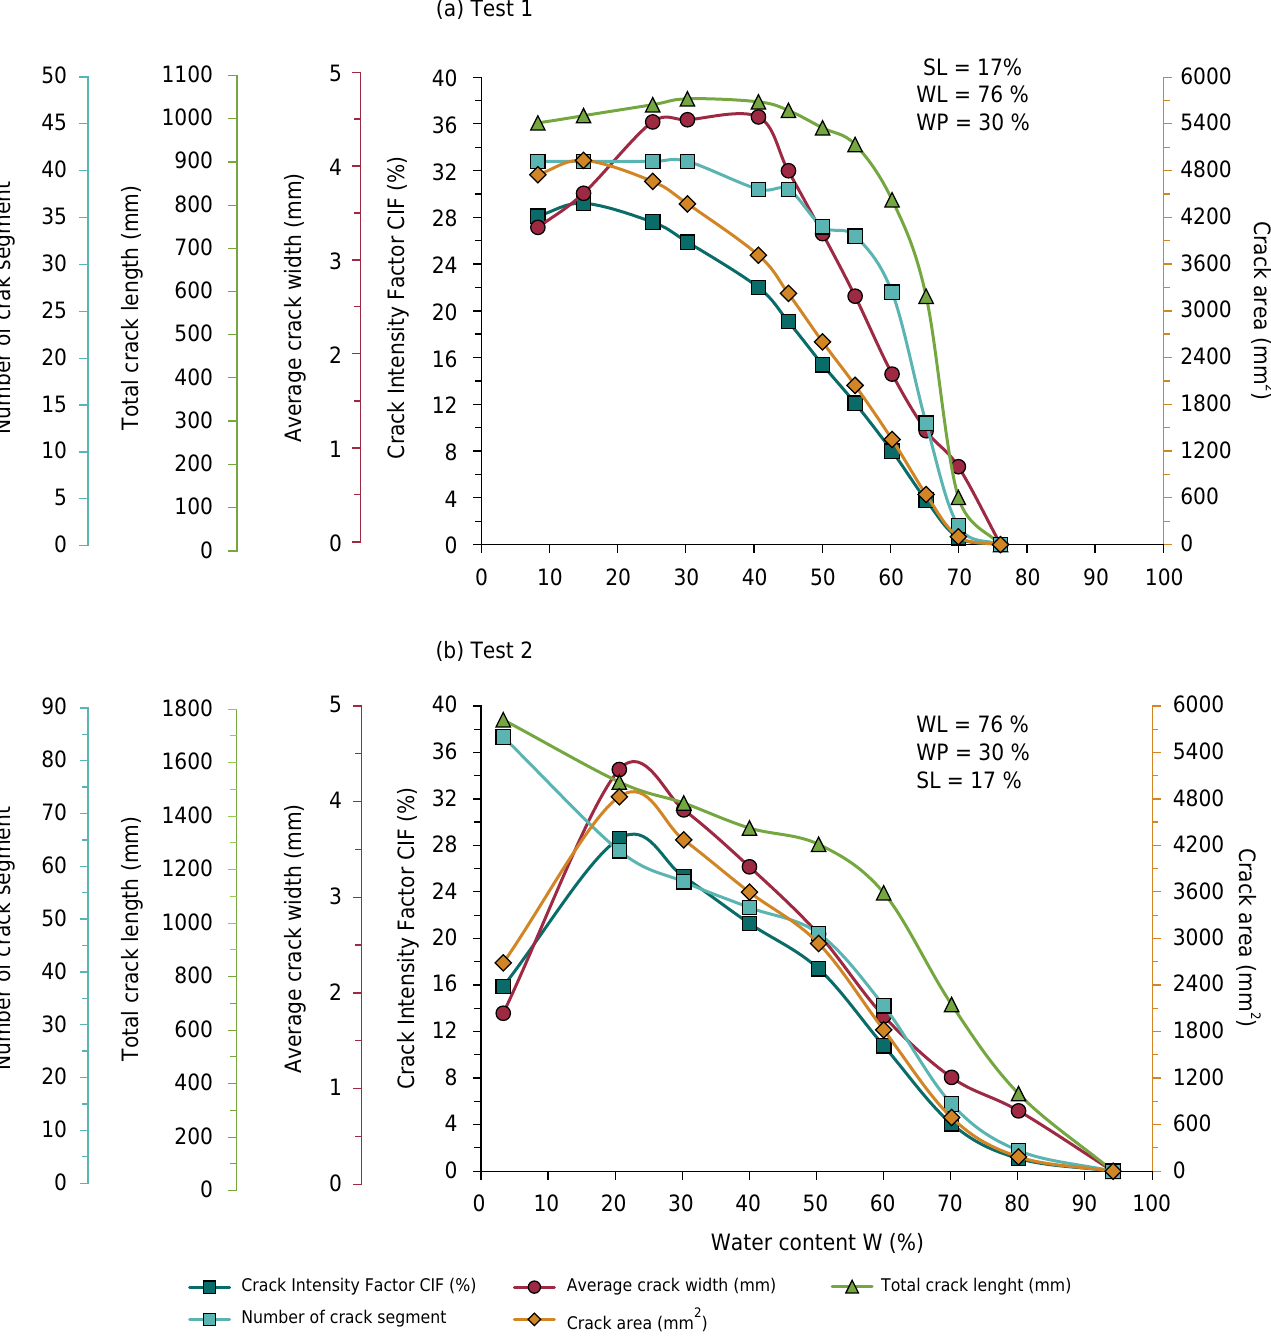
Figure 8. Quantitative evolution of geometric crack indexes while